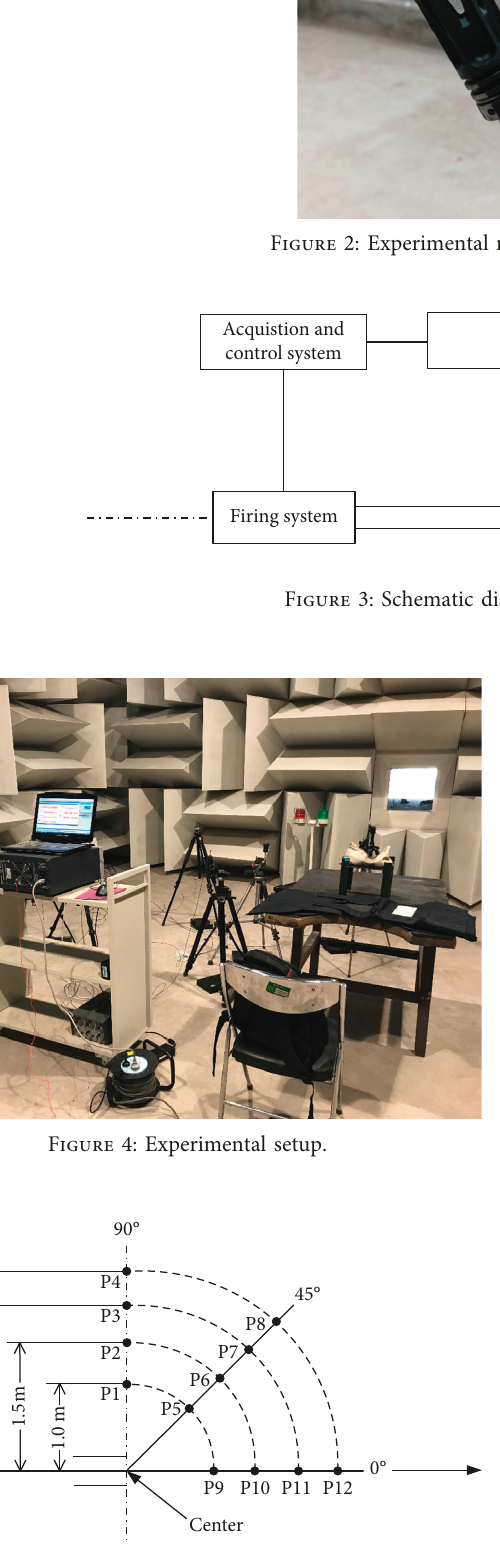
Figure 5: Measurement point locations in the far field.